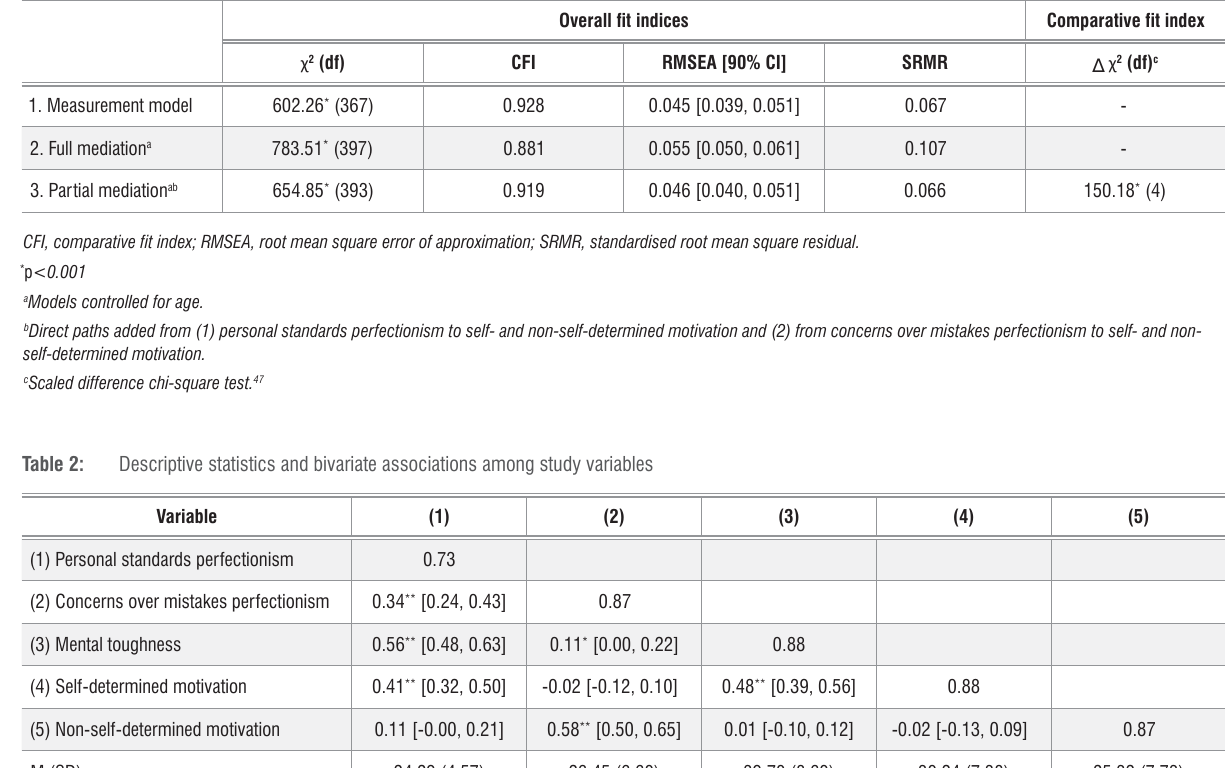
Measurement and structural model fit indices Overall fit indices Comparative fit index